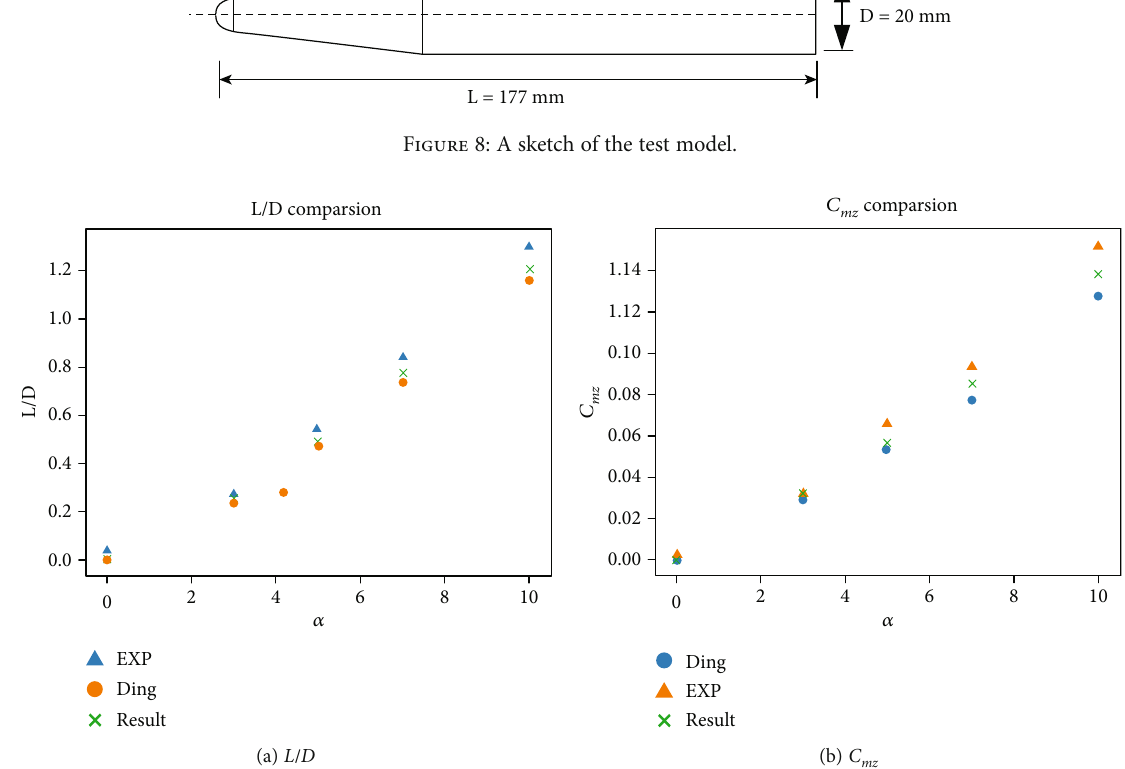
Figure 9: Lift-to-drag ratio and pitching moment comparison for the test